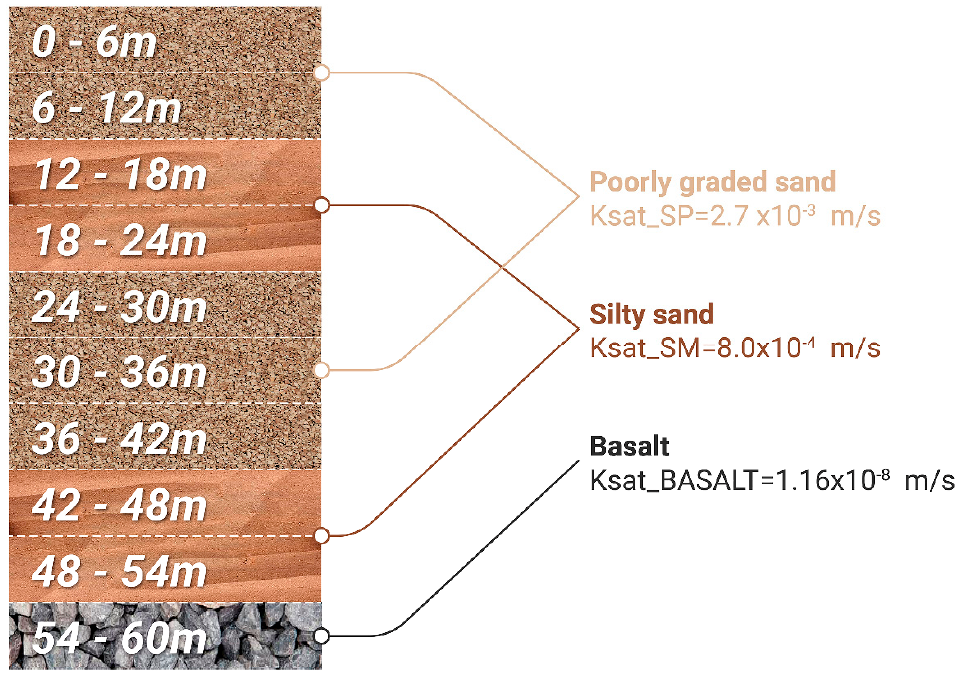
Figure 3. Mean stratigraphic profile in micro-basin of El Chicalote.